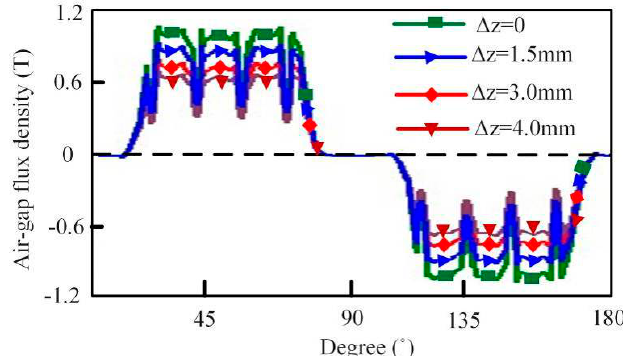
Figure 10. Distribution of air gap flux density at different CR axial displacement.